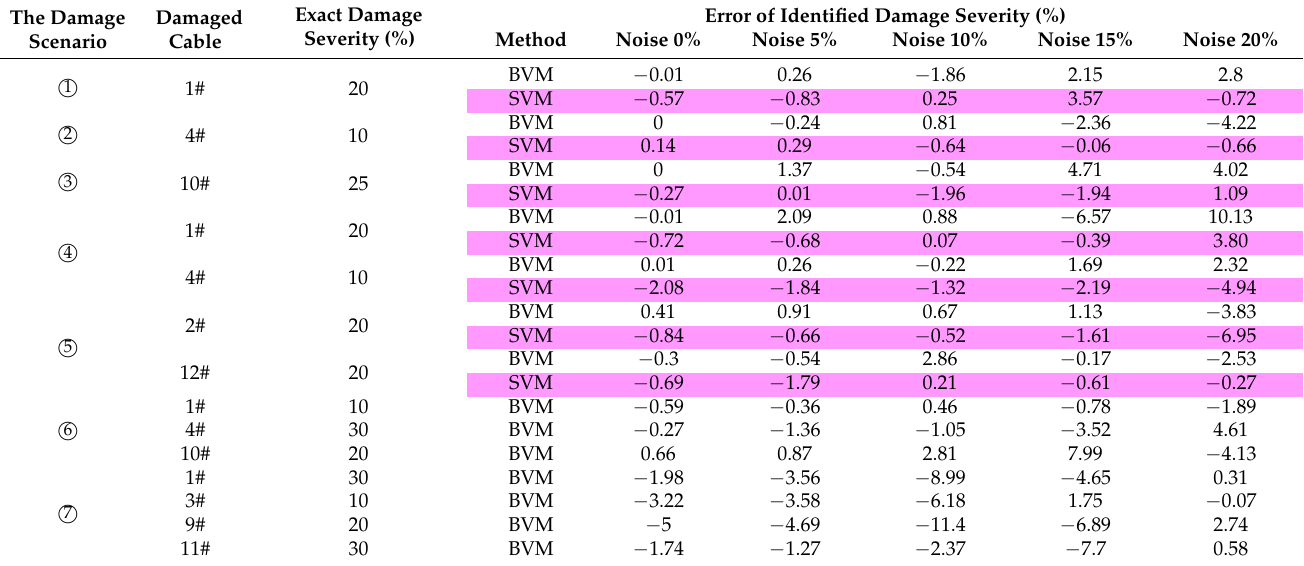
The bold italics indicate the misidentified damaged cable labels and their identified damage severity. “— —” means this item does not exist. The values in the pink zone are the identified damage severity using the SVM method [18]. Table 6. The error of the identified damage severity using the BVM method and the SVM method